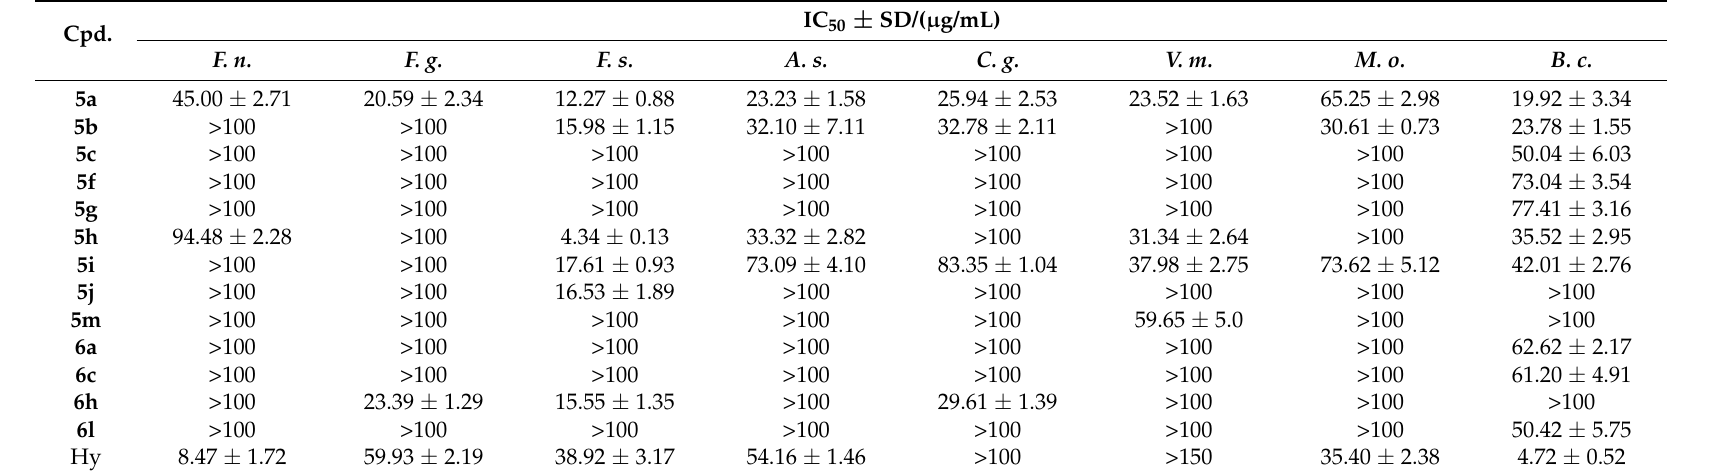
Table 2. IC 50 values of Some Compounds on Eight Phytopathogenic Fungi a